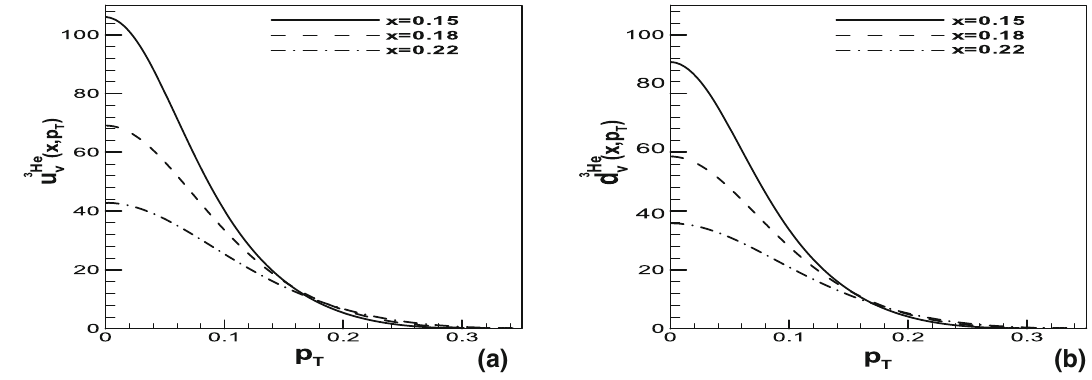
Fig. 4 The TMD sea quak distributions of 7 Li , a ¯ u ( x , p T ) , b ¯ d ( x , p T ) c s ( x , p T ) , with respect to x at p T = 0 . 05 GeV , 0 . 08 GeV and 0 . 1 GeV